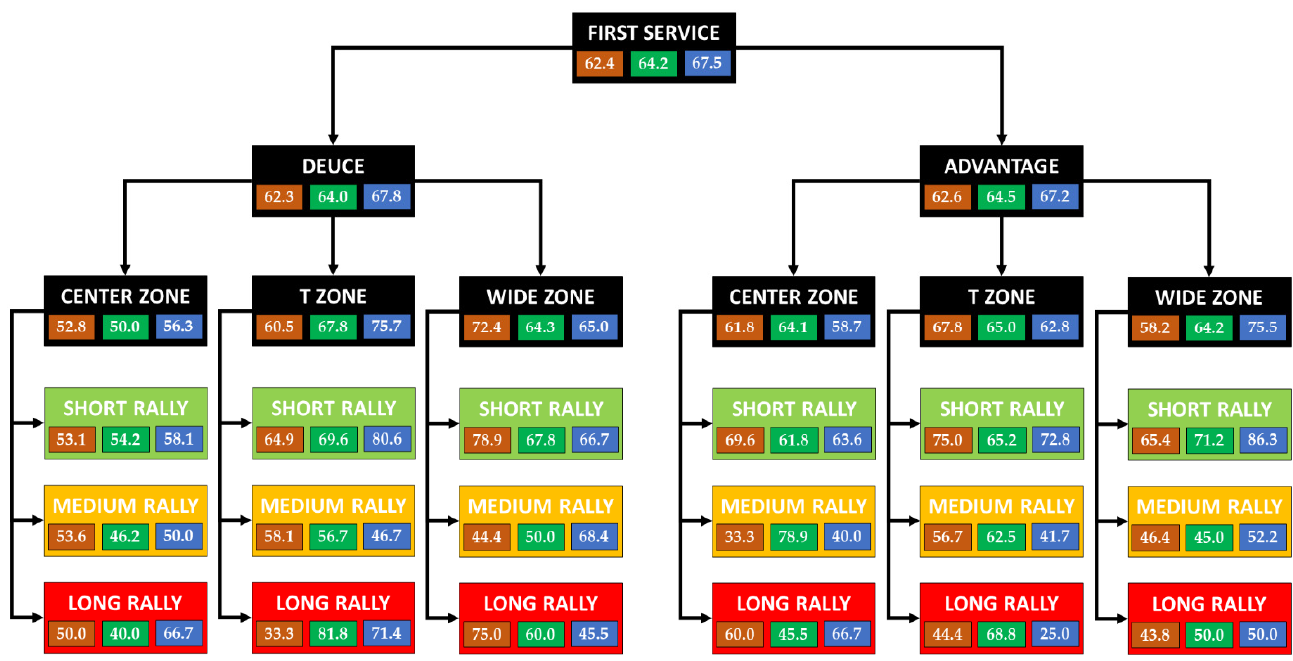
Figure 5. Efficiency analysis with the first service.